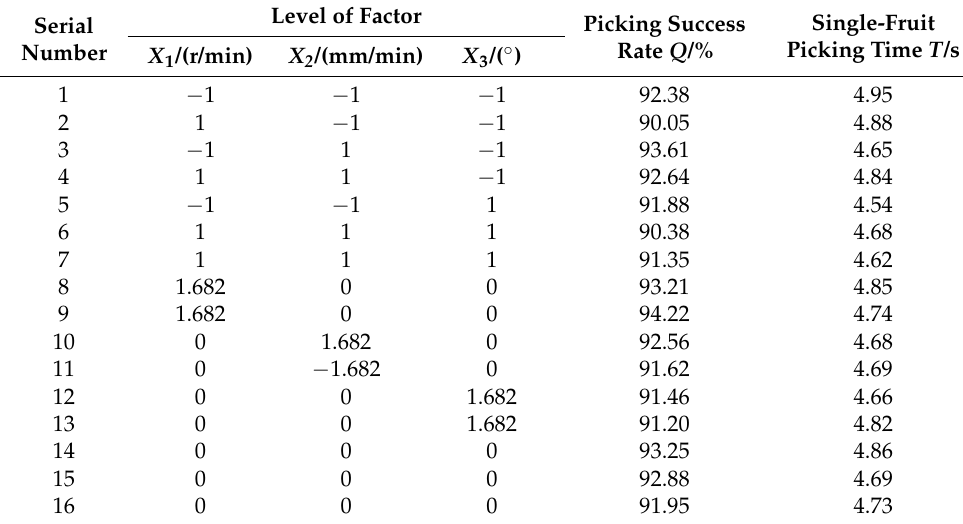
Table 3. Picking performance orthogonal test